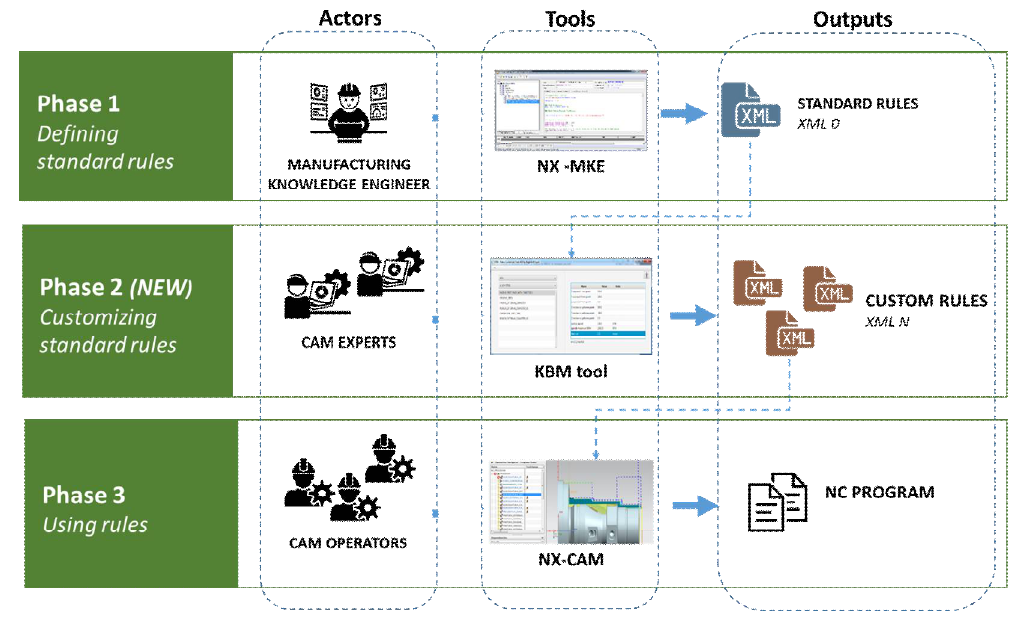
Figure 4. SPIA Knowledge-Based Manufacturing (SPIA-KBM) methodology.